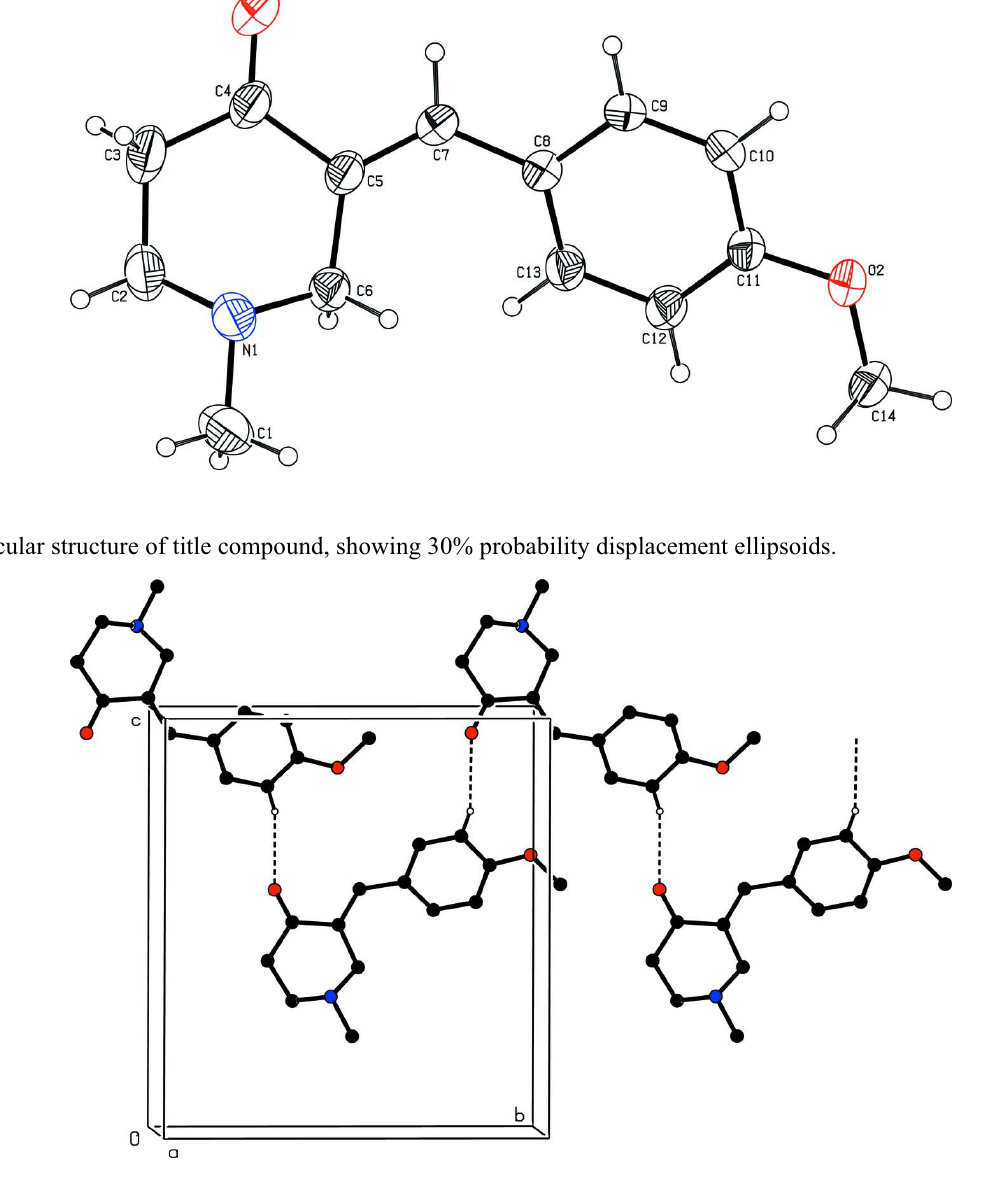
Figure 2 The molecular packing of the title compound, viewed down the a